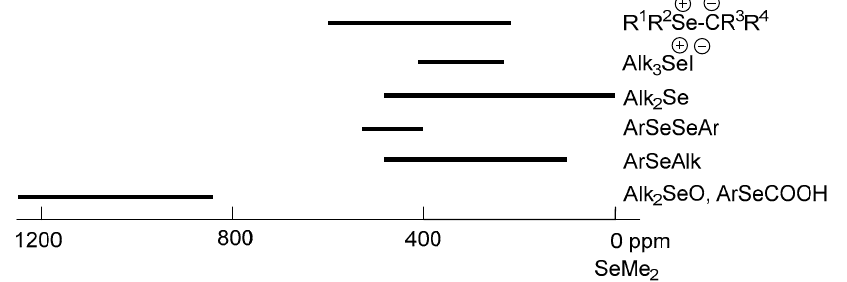
Figure 11. Figure presenting the relationship between the structure and chemical shift for the different groups of selenoorganic derivatives.